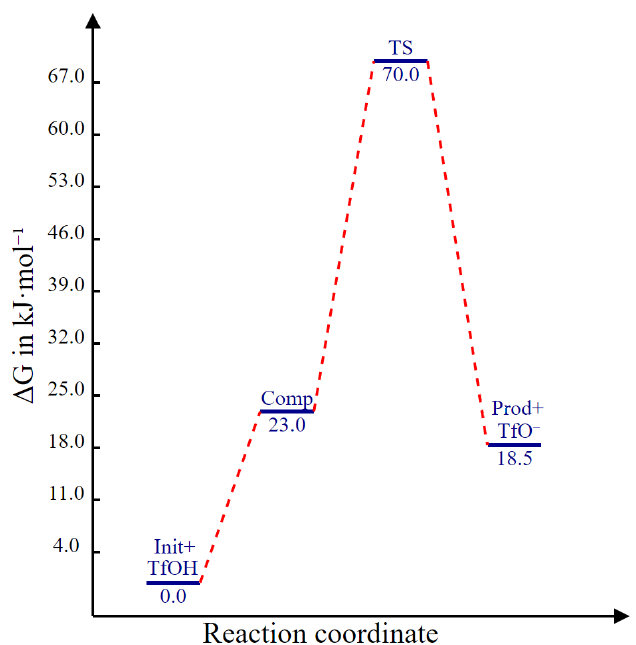
Figure 4. Energy profile of protonation of [2,6-B 10 H 8 O 2 CCH 3 ] − . TfOH–CF 3 SO 3 H, TfO − –CF 3 SO 3 − . The deciphering of other abbreviations is given in the main text. The deciphering of other abbreviations is given in the main